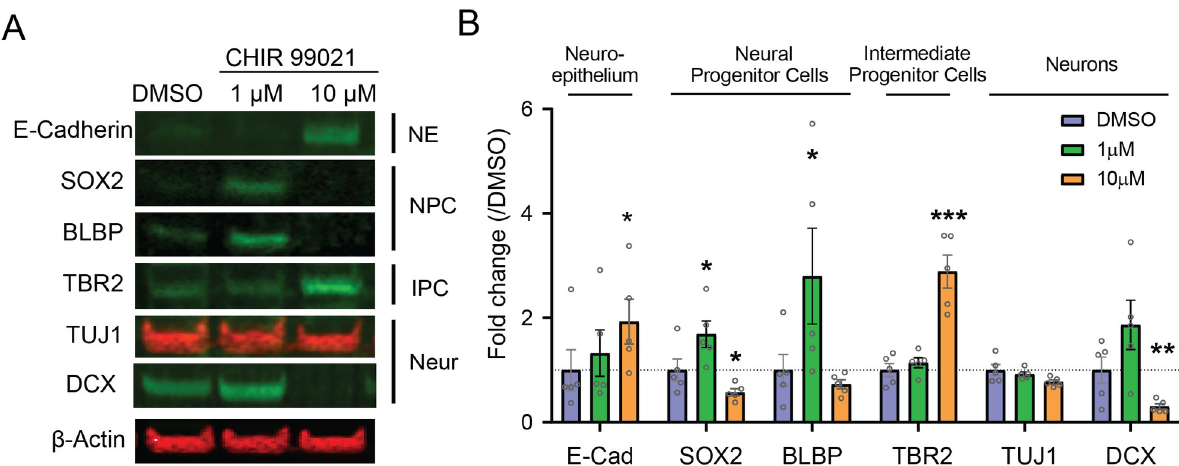
Fig 3. GSK3 β inhibition by CHIR 99021 affects neuronal differentiation of neuroepithelium in a dose dependent manner-Western Blots. A . Western Blot bands and B . quantification of neuroepithelium marker E-cadherin (E-Cad), neural progenitor cells (NPCs) marker SOX2, radial glia marker BLBP, intermediate progenitor marker TBR2, and neuronal markers TUJ1 and DCX, relative to DMSO control (n = 5 batches of organoid production for the three groups. E-cadherin: DMSO: 1 ± 0.0891; 1 μ M: 0.9285 ± 0.2585, p-value = 0.2881; 10 μ M: 1.819 ± 0.5351, � : p-value = 0.0286; SOX2: DMSO: 1 ± 0.09242; 1 μ M: 1.472 ± 0.1668, � :p-value = 0.0125; 10 μ M: 0.5228 ± 0.05321, � :p-value = 0.0405; BLBP: DMSO: 1 ± 0.01525; 1 μ M: 2.069 ± 0.7181, � :p-value = 0.0286; 10 μ M: 0.6944 ± 0.1048, p-value = 0.8825; TBR2: DMSO: 1 ± 0.1263; 1 μ M: 1.141 ± 0.09633, p-value = 0.4000; 10 μ M: 2.884 ± 0.3168, ��� : p-value = 0.0006; TUJ1: DMSO: 1 ± 0.1075; 1 μ M: 0.9262 ± 0.04413, p-value = 0.5429; 10 μ M: 0.7731 ± 0.0886, p-value = 0.0823; DCX: DMSO: 1 ± 0.2530; 1 μ M: 1.864 ± 0.4717, p-value = 0.1449; 10 μ M: -1.516 ± 0.0886, p-value = 0.0044, unpaired t-tests).